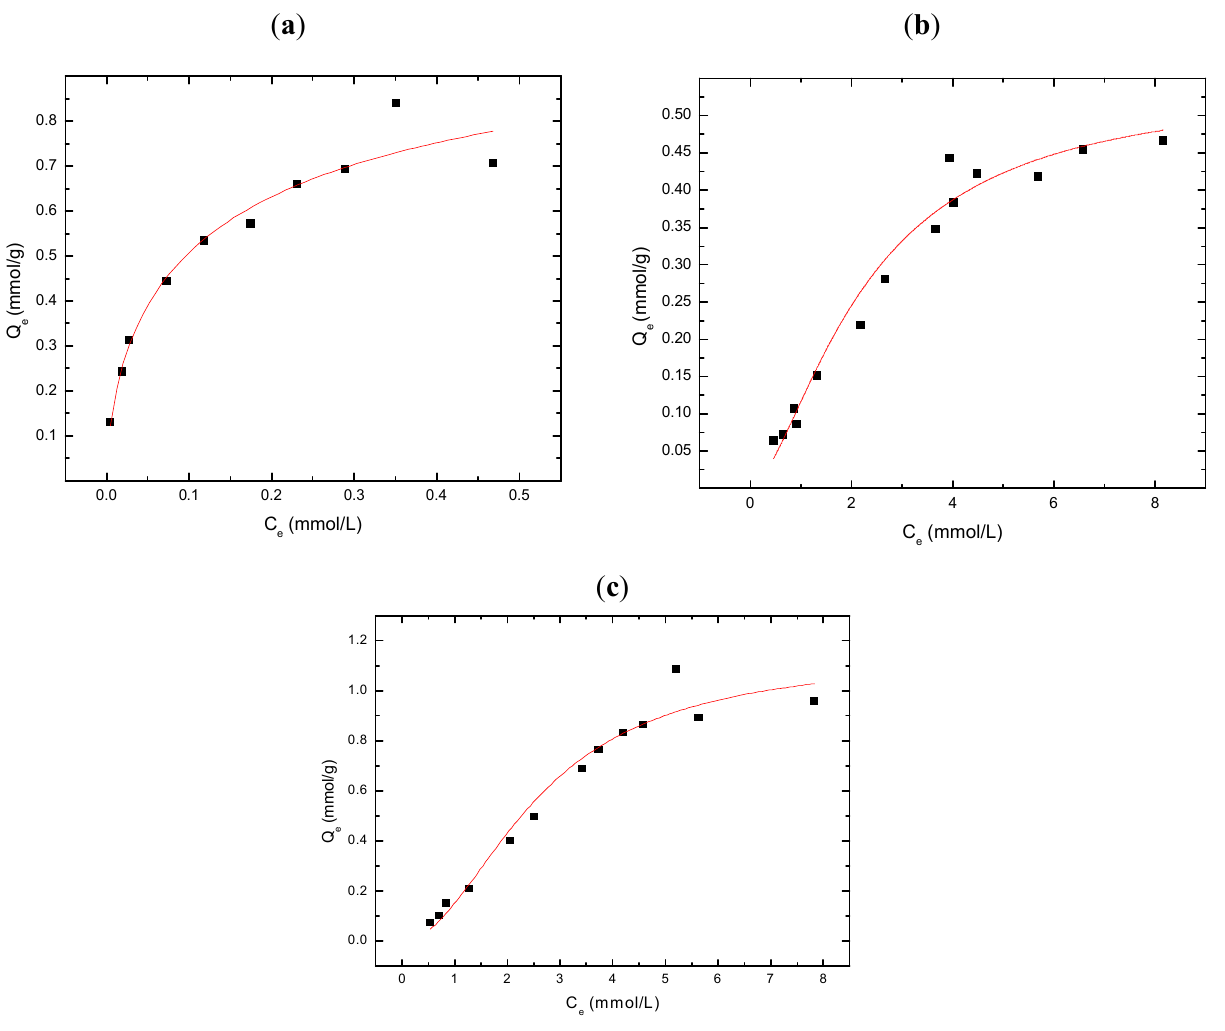
Figure 1. Sorption isotherms for 2,4-DCP with various sorbents at pH 9.0 and 295 K; ( a ) GAC; and ( b ) MDI-3, and ( c ) CDI-3. The solid line represents the best-fit curve according to the Sips isotherm (Equation